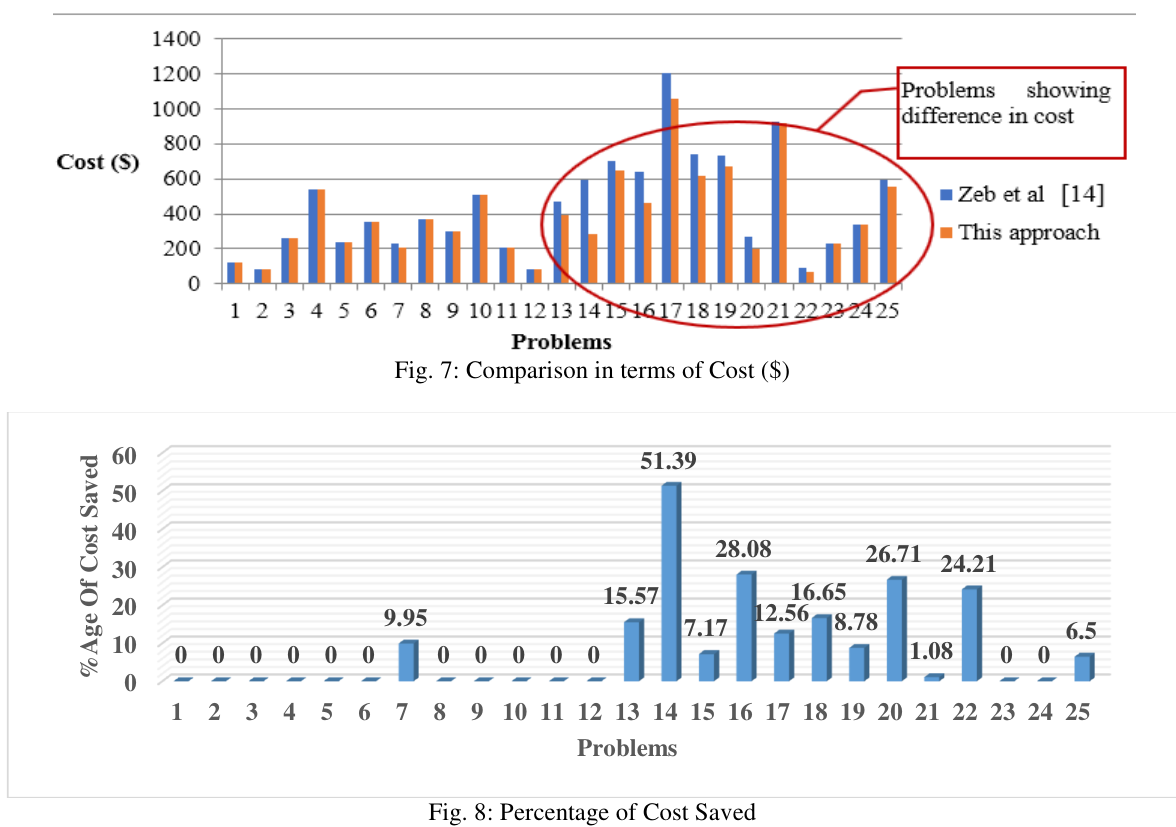
Fig. 8: Percentage of Cost